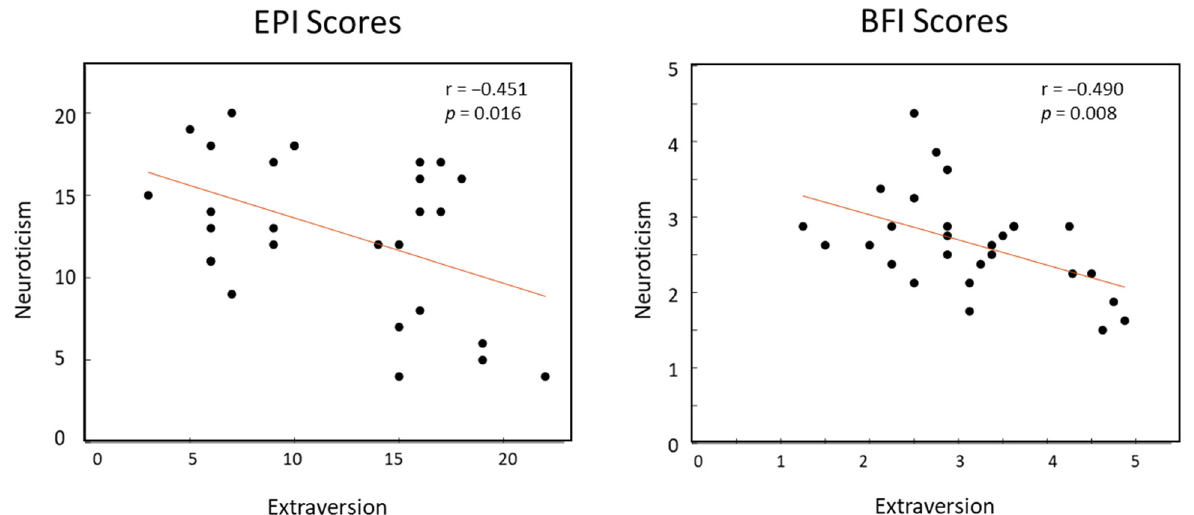
Figure 1. Correlation between neuroticism and extraversion index through EPI ( left ) and BFI ( right ) scores.